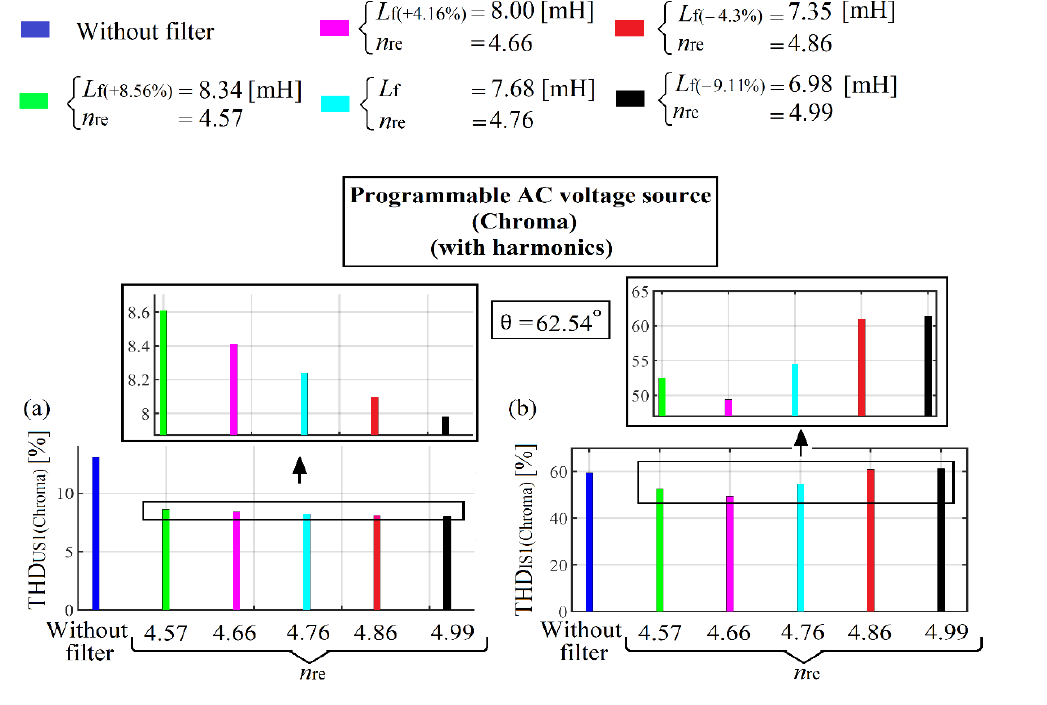
Figure 62. PCC voltage ( a ) and current ( b ) THD.